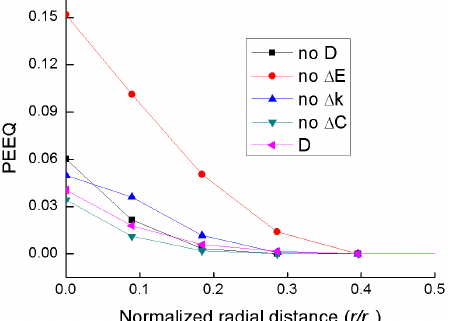
Figure 5: The influence of rock damage on plastic strain.